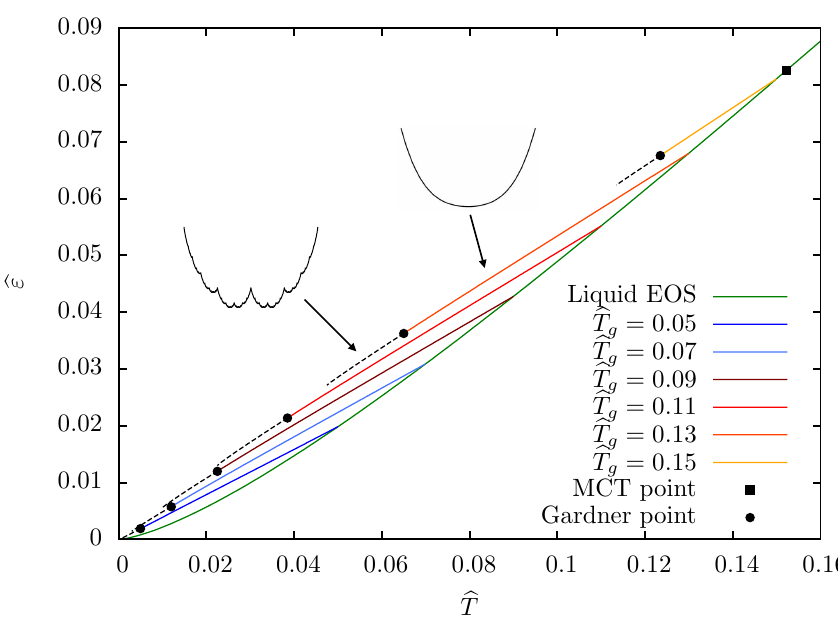
(cid:34) (properly scaled with the dimension d ) as a function (cid:98) ϕ = 8, ) and then followed when the (cid:98) T g (cid:98) g